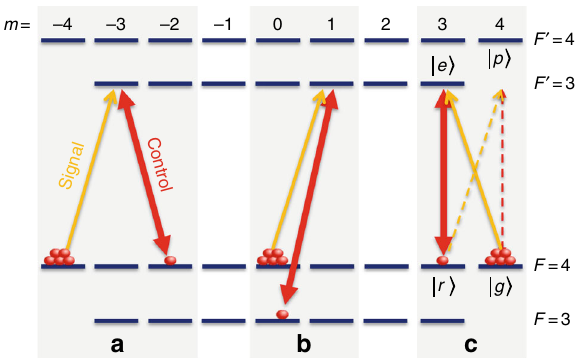
Fig. 1 Con fi gurations of light storage on the cesium ground-level. a Zeeman coherence Δ m j j = 2. b Hyper fi ne coherence Δ m j j = 0. c Zeeman coherence Δ m j j = 1, associated with spin orientation, used here. The dashed arrows represent an additional weak process, discussed in the text. In 133 Cs, the ground and excited state hyper fi ne splittings are 9.19 and 1.17 GHz respectively, and the Doppler width of the optical linewidth is 370 MHz at T = 40 °C. Note that the signal is stored and retrieved as a linearly- polarized fi eld, despite the fact that only one of its circular-polarization components (solid yellow line) enters the Λ -system g j i (cid:2) e j i (cid:2) r j i ,